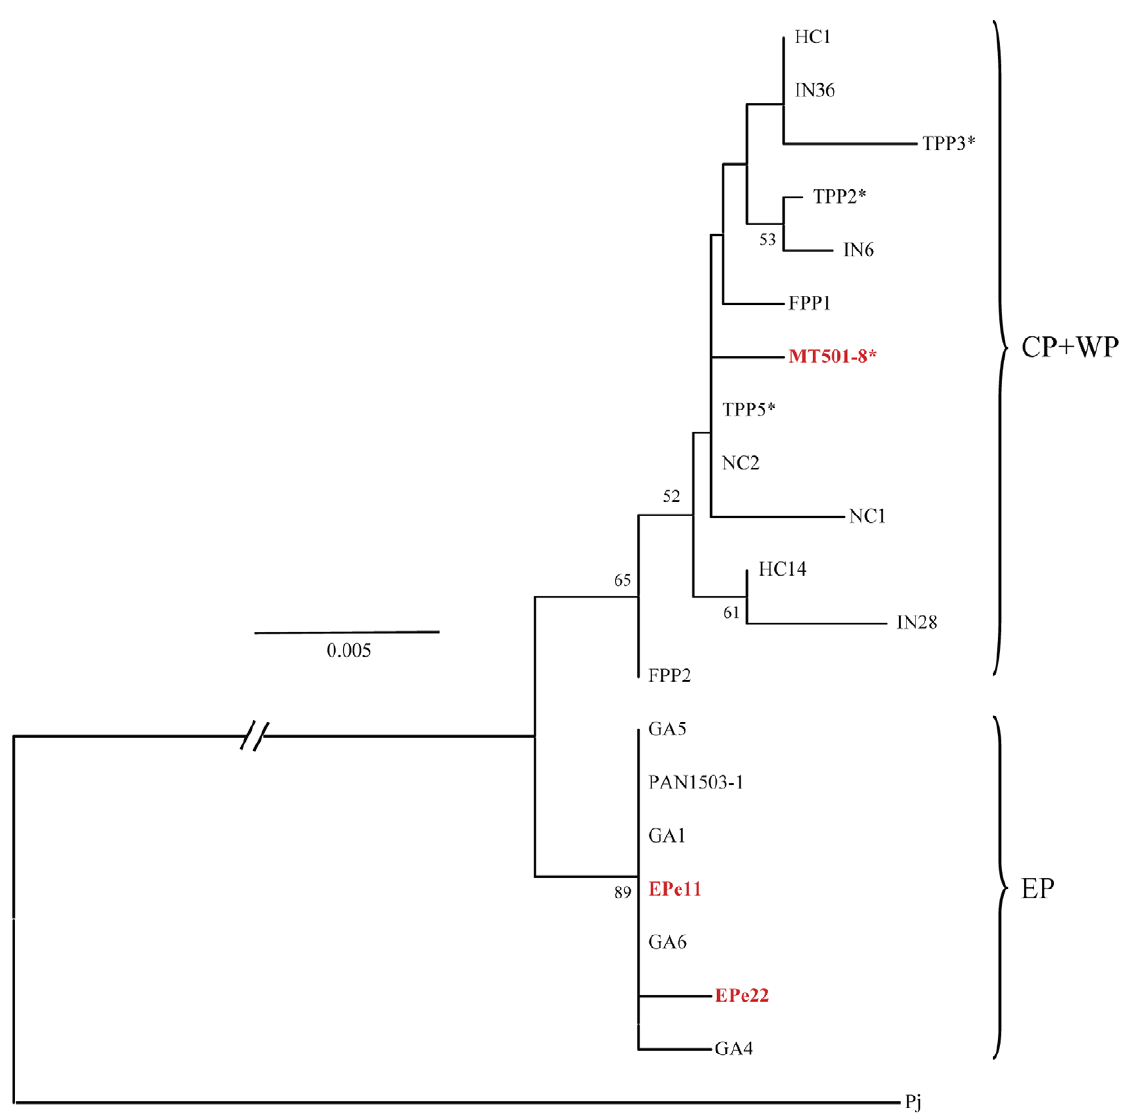
Figure 4. Neighbor-joining phylogenetic tree drawn using 536 bp 16S rDNA sequences of 20 individuals collected in the Eastern (EP), Central (CP) and Western Pacific (WP). The homologous sequence of Panulirus japonicus (NC_004251) [21] is used as an outgroup (Pj). Bootstrap supports higher than 50% and number with a branch indicates probability for 1,000 replications. Larval samples are shown in red. Samples carrying asterisk are from Central